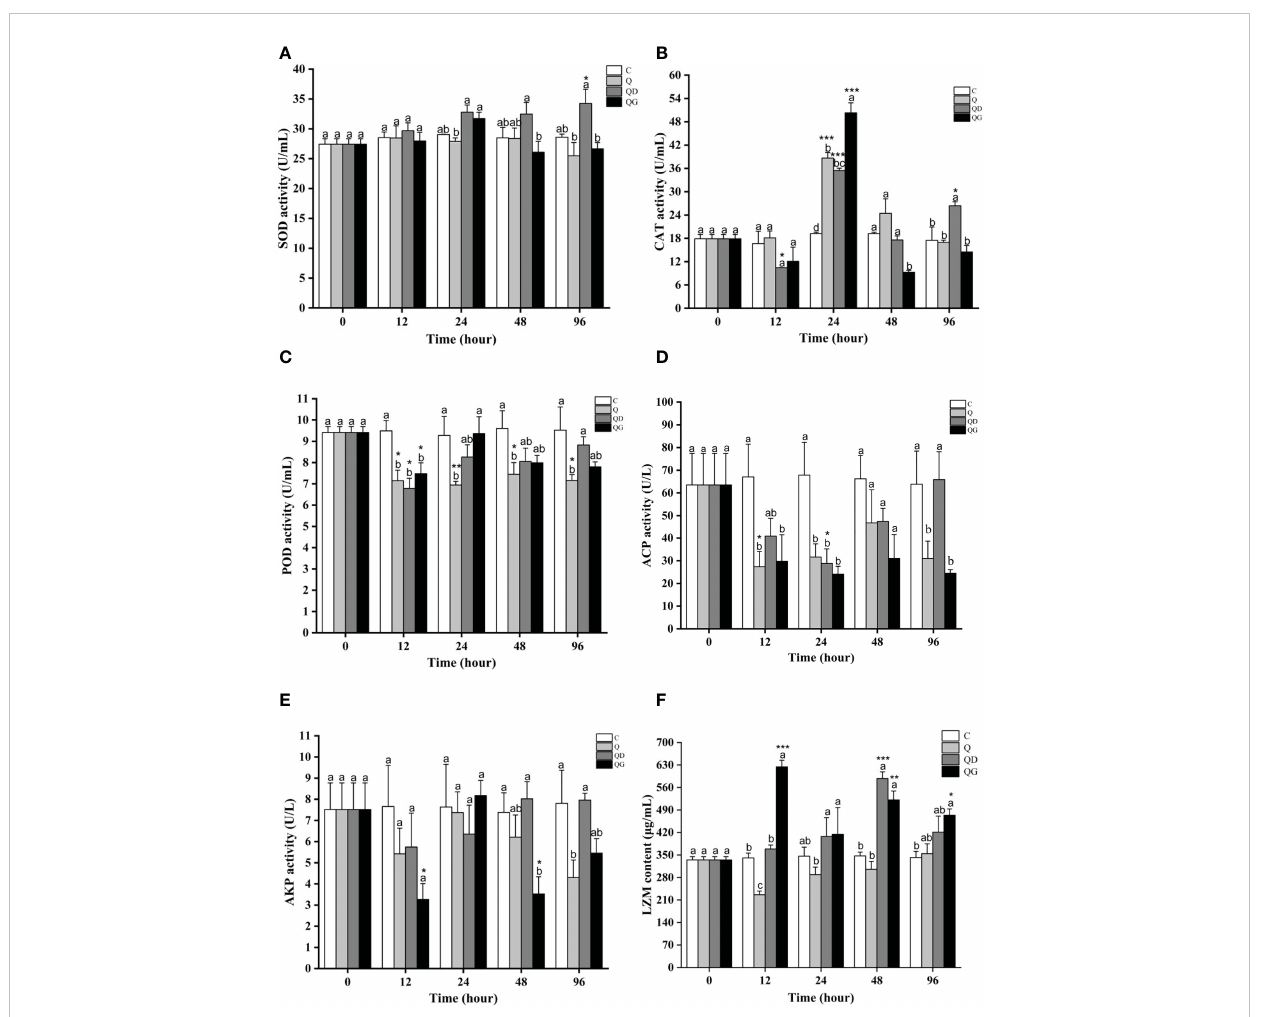
FIGURE 2 The activities of immune-related enzymes after 96 h of exposure to hypoxia alone or sul fi de in combination (C, Q, QD, and QG stand for the control group, hypoxia group, hypoxia and mild-sul fi de group, hypoxia and high-sul fi de group, respectively). Different letters indicate values that are signi fi cantly different among the treatments within each time point, and the asterisk *, ** and *** indicate signi fi cant difference ( P < 0.05) and highly signi fi cant difference ( P < 0.01, P < 0.001) under the same treatment conditions. (A) : SOD activity; (B) : CAT activity; (C) : POD activity; (D) : ACP